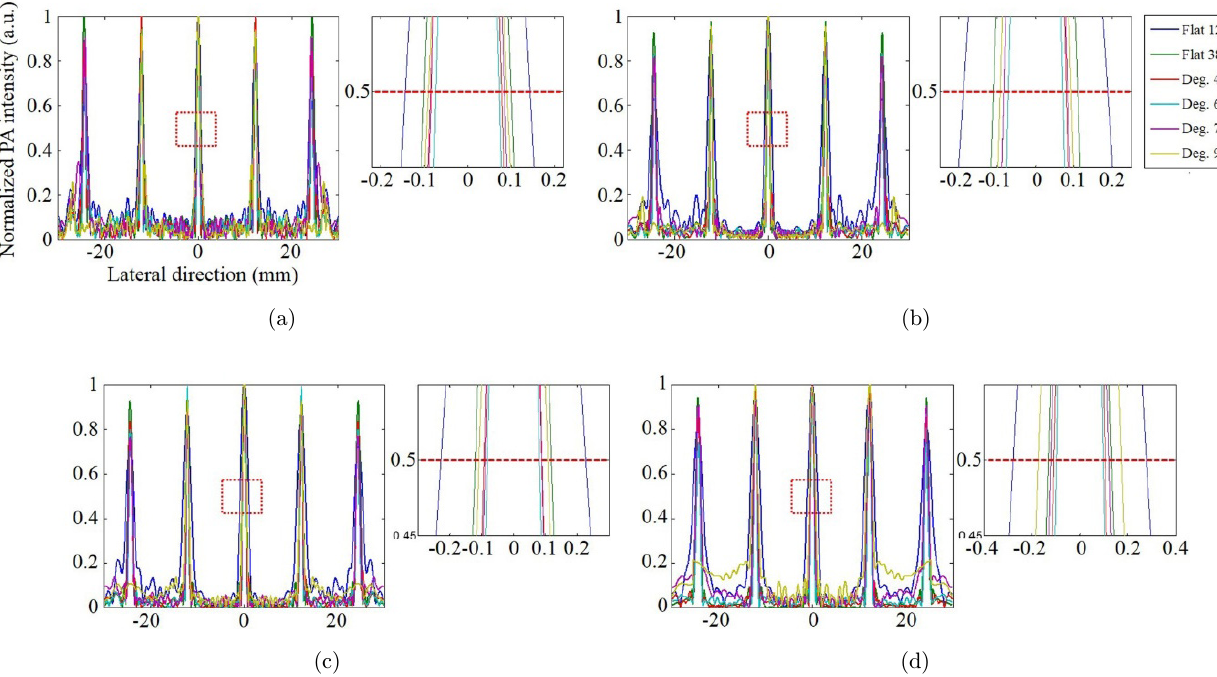
Fig. 6. (Color online) Quantitative analysis of enhanced resolution in synthetic aperture PAT. Lateral pro¯les of the normalized PA intensity along the point targets in the (a) second, (b) third, (c) fourth, and (d) ¯fth rows from the indicated aperture orientation. The box shown to the right of each plot is the zoom-in area corresponding to the dashed red